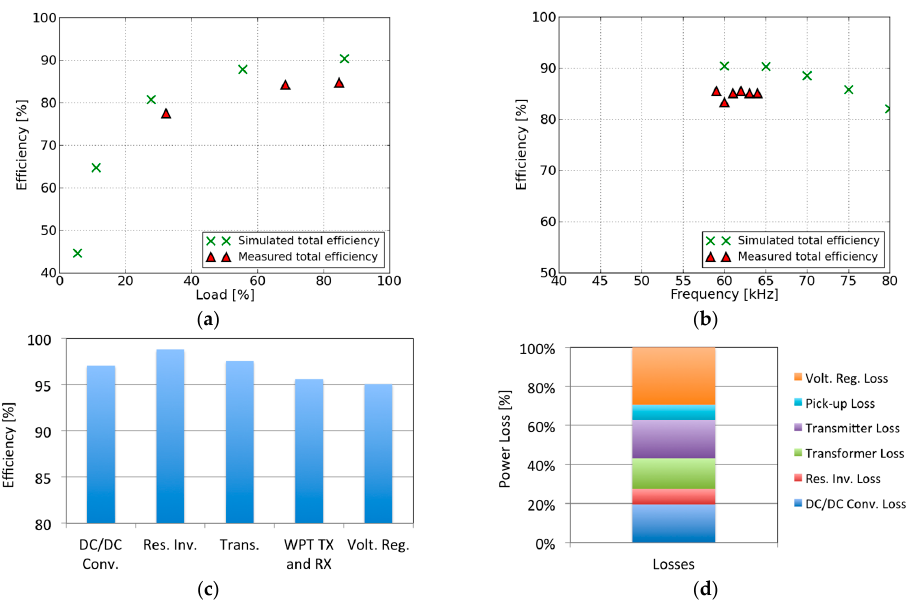
Figure 12. Measured efficiency and loss of the test-bed: ( a ) total efficiency vs. load; ( b ) total efficiency vs. operating frequency; ( c ) measured efficiencies of the components; and ( d ) measured losses of the developed system.